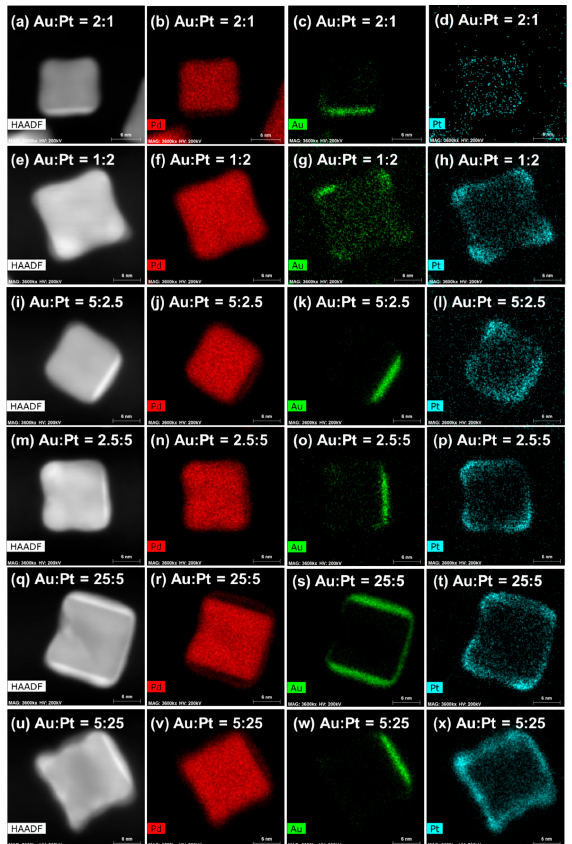
Figure 2. The energy dispersive spectroscope (EDS) mapping images of AuPt@Pd nanoparticles synthesized with varying mol% ratio of Au and Pt. The mol% of Au:Pt were ( a – d ) 2:1, ( e – h ) 1:2, ( i – l ) 5:2.5, (m–p) 2.5:5, ( q – t ) 25:5, and ( u – x ) 5:25. Scale bar indicates 6 nm.